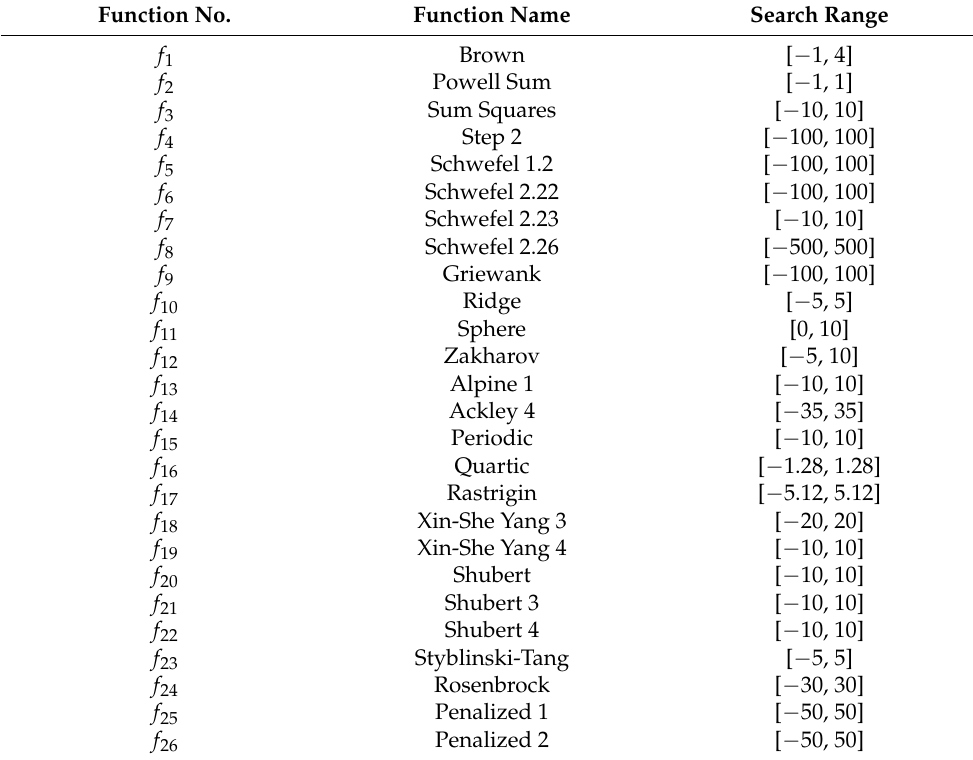
Table 1. The benchmark functions. Function